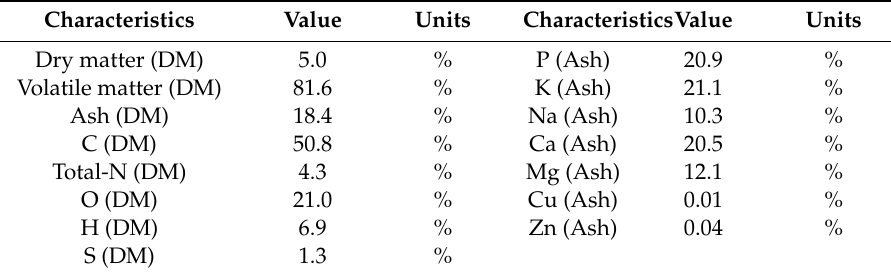
Table 1. Characteristics of swine manure under the current